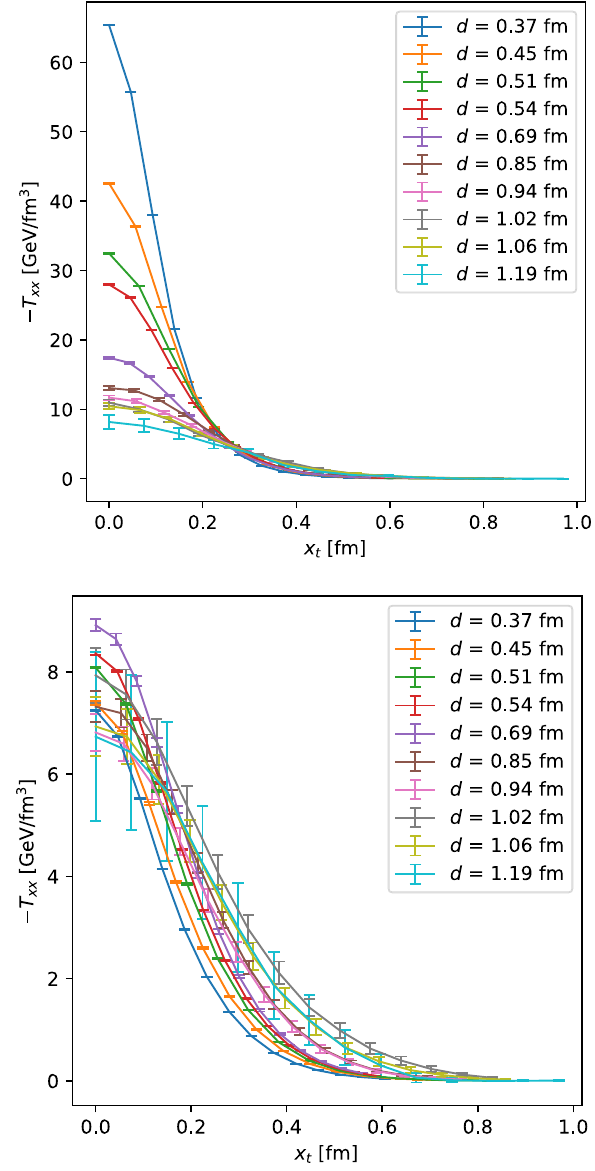
Fig. 12 ComparisonofthediagonalcomponentsoftheMaxwellstress tensor for the different quark–antiquark separations, recovered from the full field E x (top) and from the non-perturbative field E